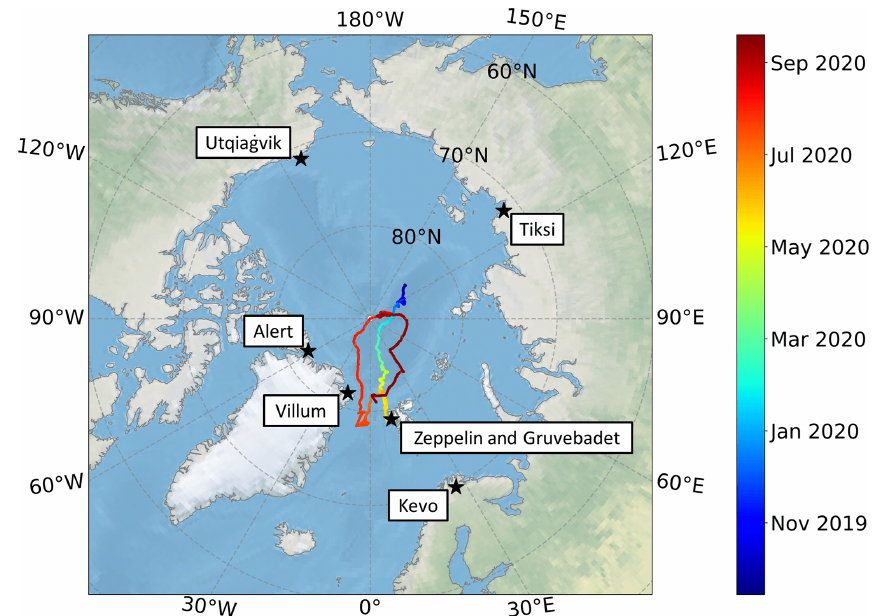
Figure 1. The drift track during MOSAiC. The color bar depicts the time of year. The black stars show the locations of the land-based sites across the Arctic that are referred to in this study. Note that Zeppelin and Gruvebadet are both located in Ny-Ålesund, Svalbard, Norway; however, the two stations are located at different altitudes. Gruvebadet is ∼ 50ma.s.l., whereas Zeppelin is ∼